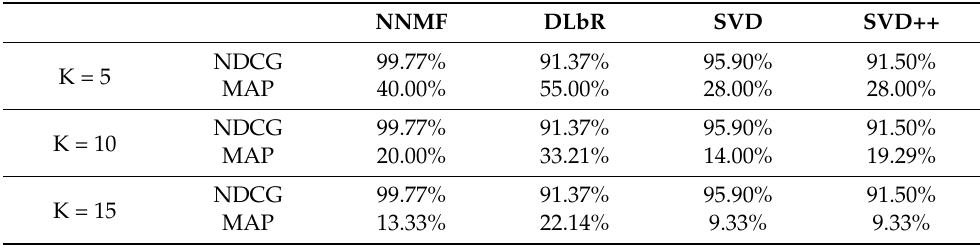
Table 8. Rank-based metrics for the four models using 𝐷𝐴𝑇𝐴 𝑝𝑟𝑢𝑛𝑒𝑑 𝐵𝐸𝑅𝑇2 dataset.